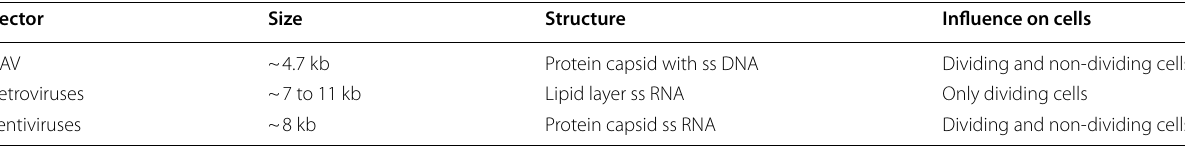
Table 3 Involvement of vectors in miRNA-based delivery